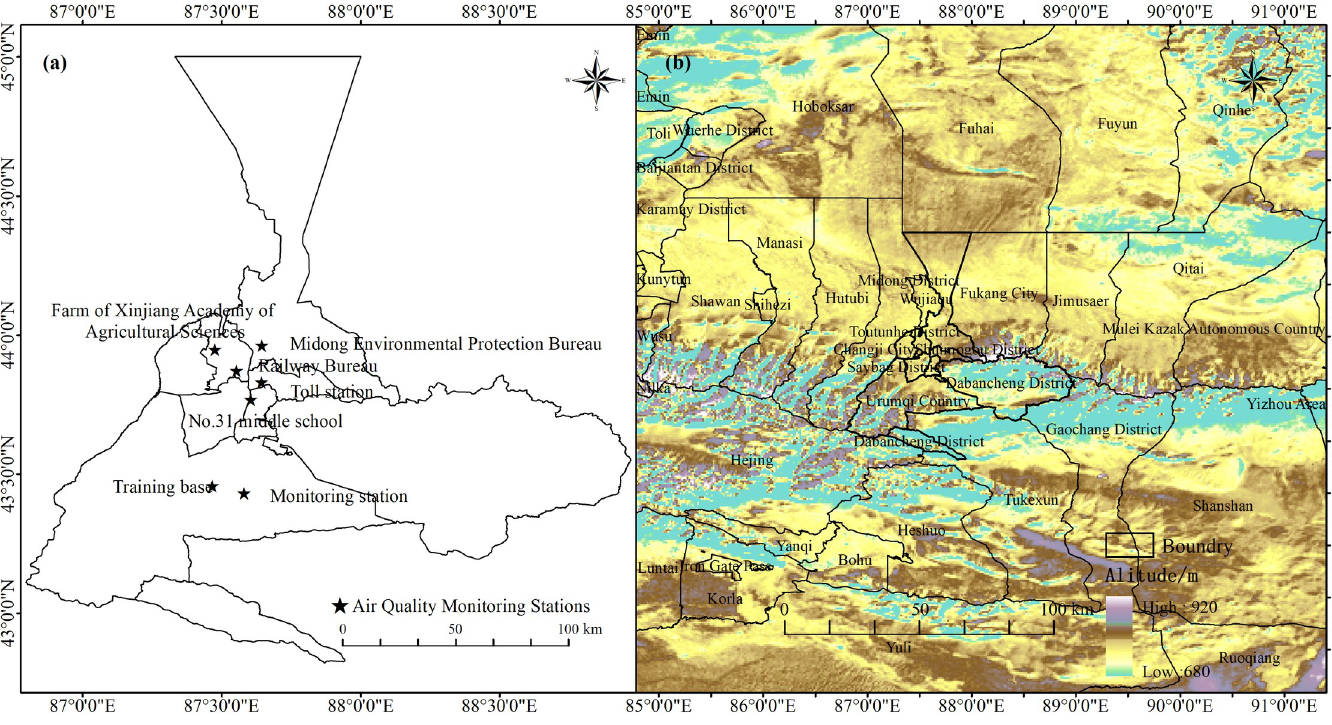
PLOS ONE | https://doi.org/10.1371/journal.pone.0249563 April 20,